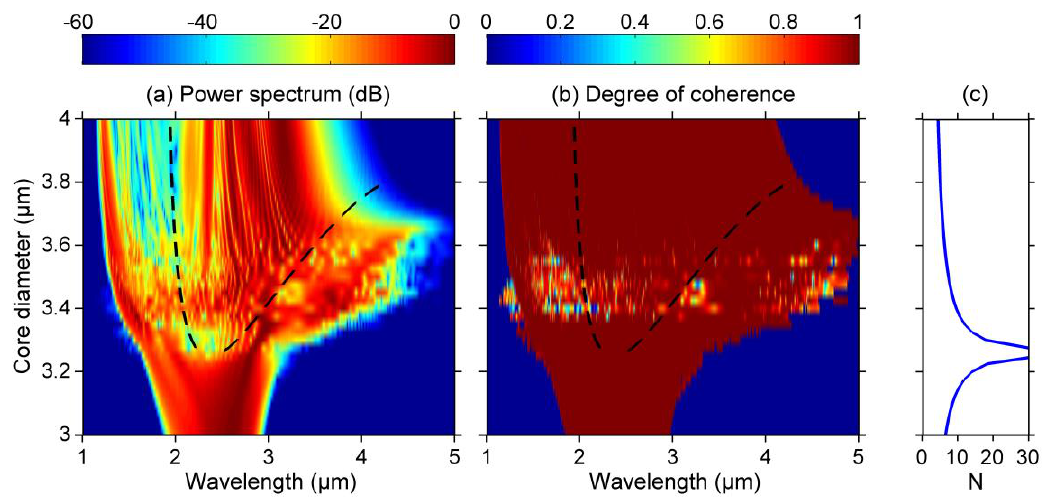
Figure 9. ( a ) Evolution of the average SC spectrum. The pump wavelength is now fixed at 2500 nm with 200-fs pulses and 3 kW peak power. The fiber length is 12 cm. ( b ) Corresponding evolution of the modulus of the complex degree of first-order coherence. ( c ) Corresponding soliton number calculated at pump wavelength.